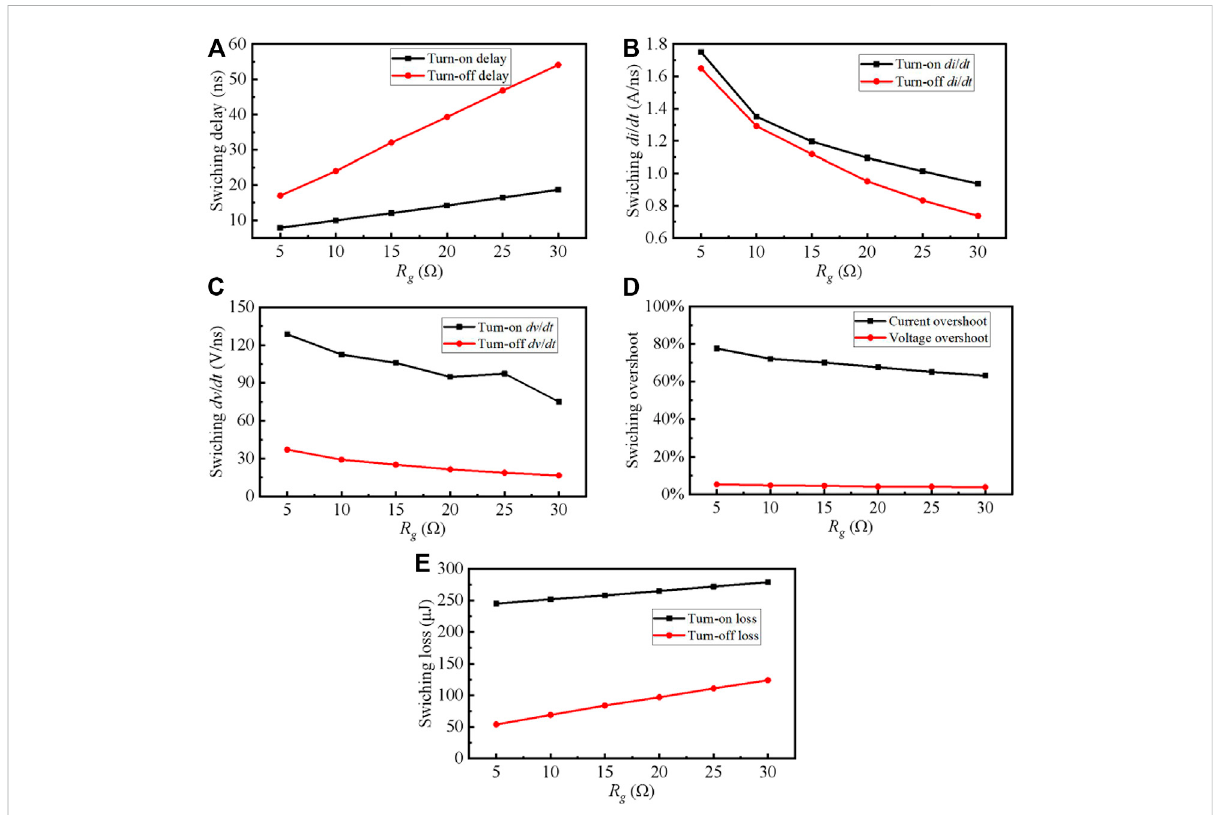
FIGURE 5 Dynamic characteristics of the SiC MOSFET with different R g . (A) Switching delay. (B) Switching di / dt . (C) Switching du / dt . (D) Switching overshoot. (E) Switching loss.